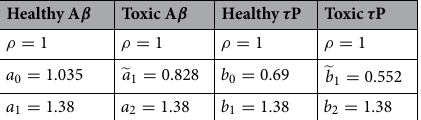
Table 1. Fixed parameter values for the primary